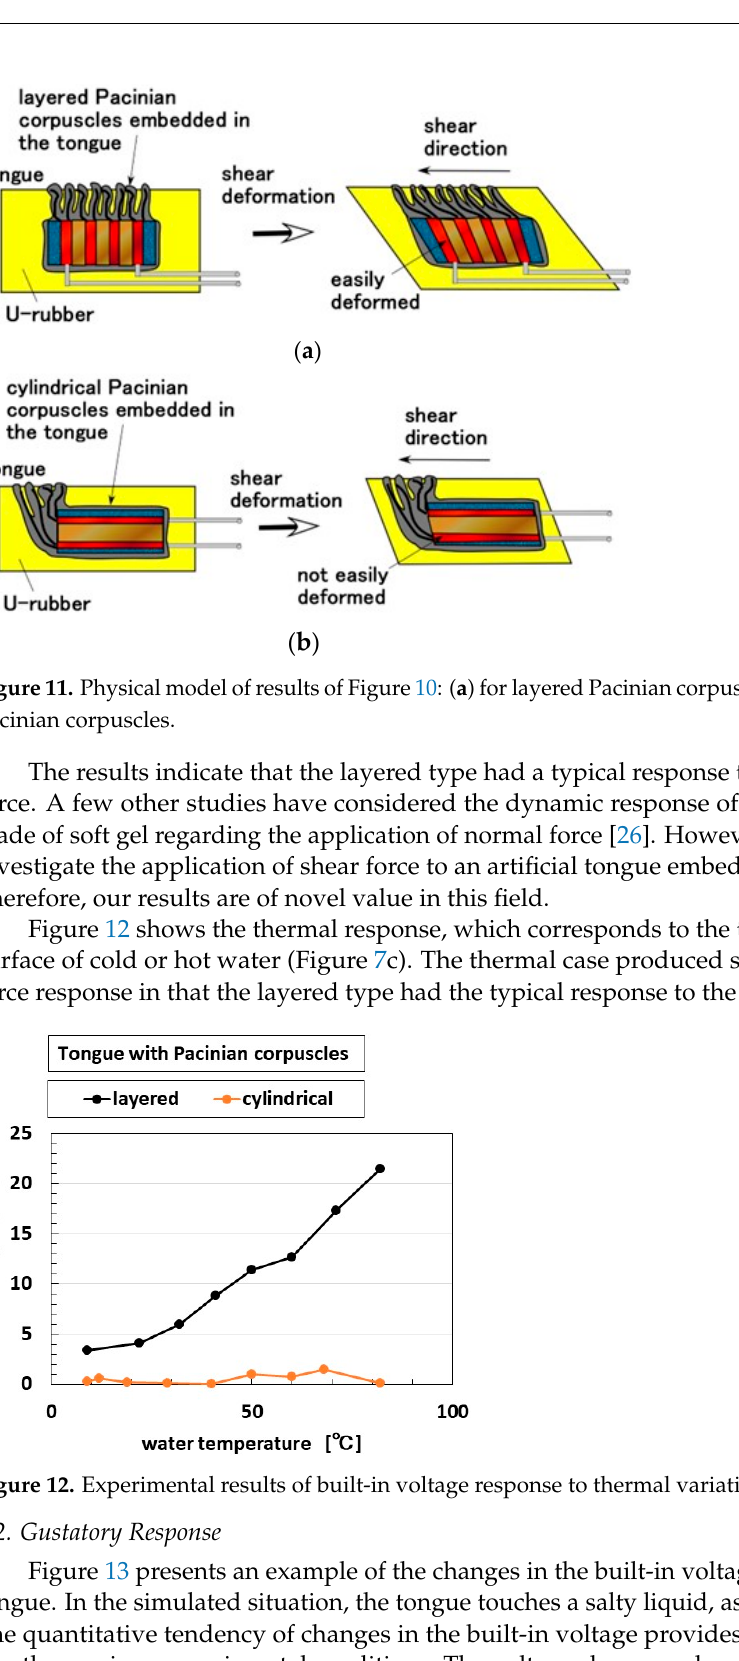
Figure 10. Experimental results of built-in voltage by shear force: ( a ), ( b ) for layered Pacinian cor-